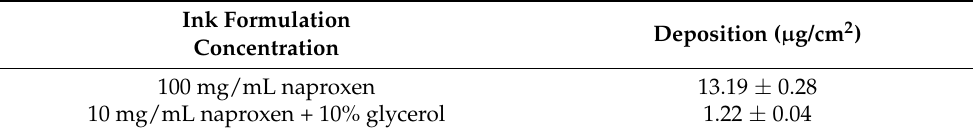
Table 3. Deposition analysis of printed samples of naproxen nanosuspensions at 100 and 10 mg/mL concentration.